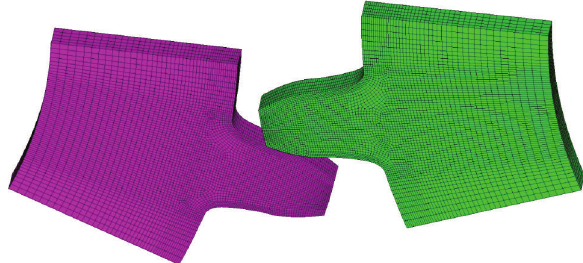
Figure 3: The 3D finite element model of microsegment gear.